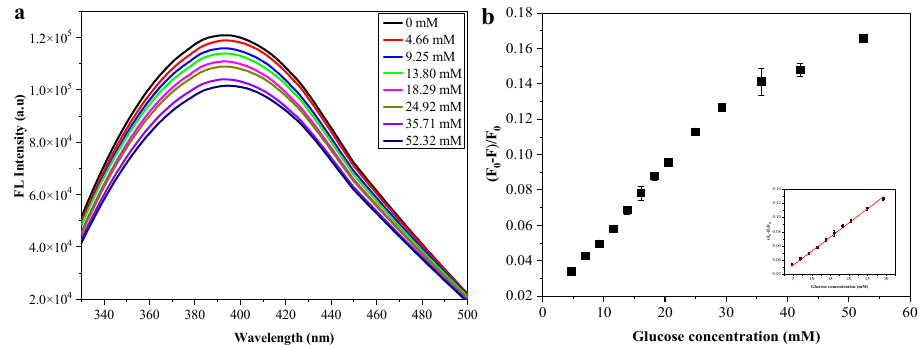
Figure 6. ( a ) Fluorescence spectra and ( b ) the variation of the fluorescence of poly(VPBA-AAm)-CD versus glucose concentration. The inset is the linear fitting plot of (F 0 − F)/F 0 versus glucose concentration (C poly(VPBA ‐ AAm) ‐ CD = 1.75 mg/mL, PBS, pH=7.4, λ ex = 310 nm).